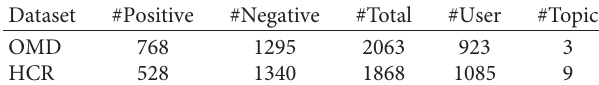
Table 1: Statistics of OMD and HCR datasets.